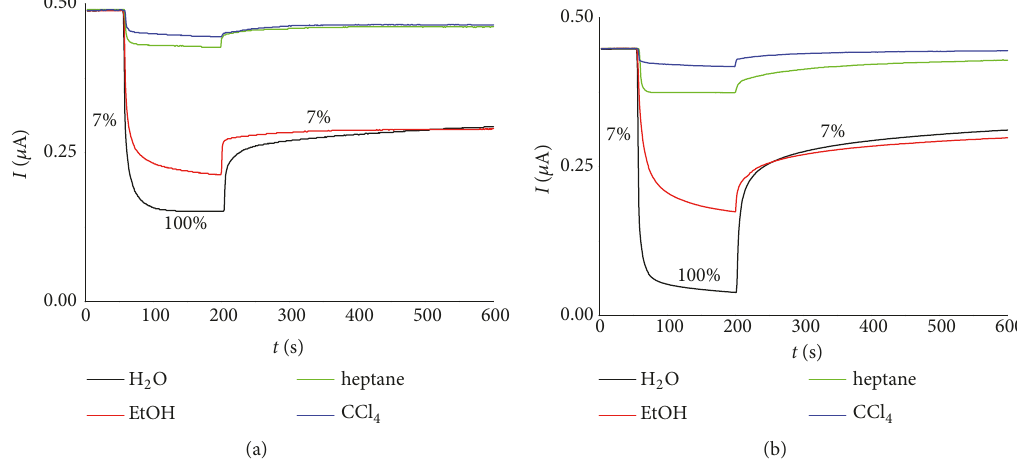
Figure 5: Changes in the conductivity of c-FLGS (a) and a-FLGS films (b) in vapors of solvents of different chemical nature.